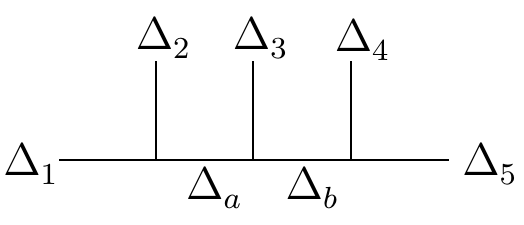
Figure 4. The 5-point partial wave, de(cid:12)ned in eq.